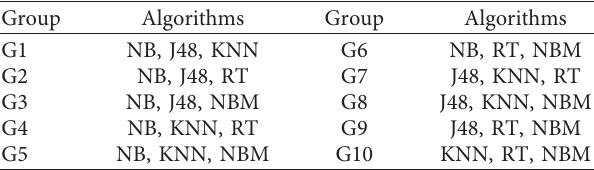
Table 4: Combinations of classification algorithms. Group